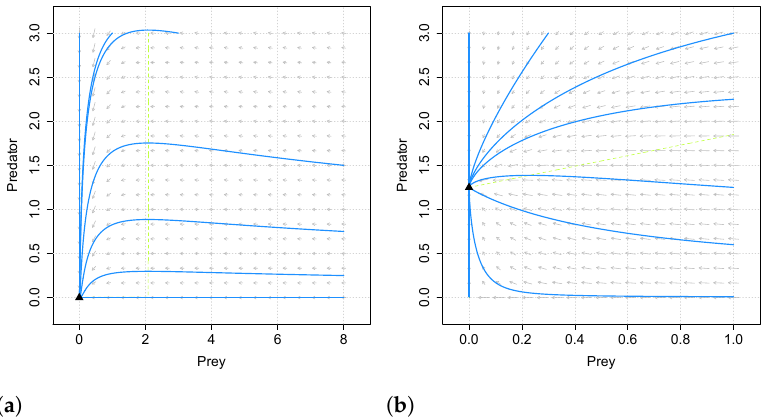
Figure 6. Dynamic behaviors with r = 0.5, s = 3, d = 0.8, a = 1.5, p = 0.6, c = 0.8, d 1 = 0.8 and n = 1. ( a ) Extinction of both species in system (19). ( b ) Extinction of prey in system